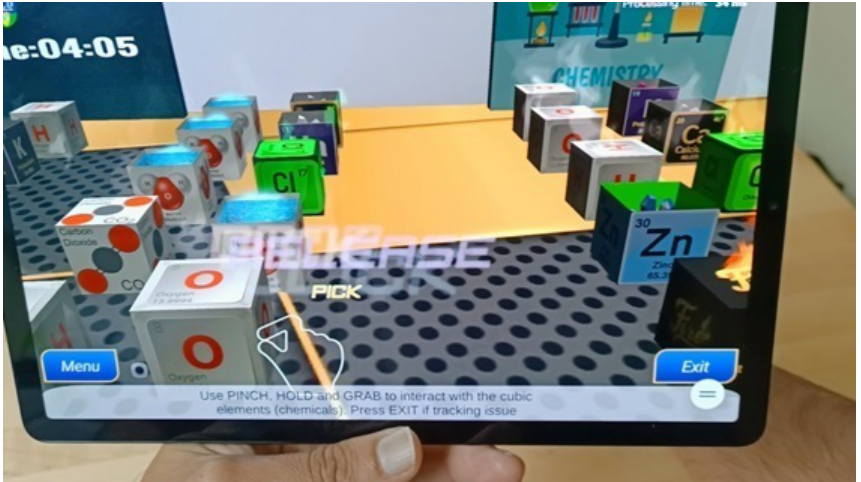
Figure 12. Touchless hand interaction for learning chemical reactions using hand tracking (real-time hand interaction) in